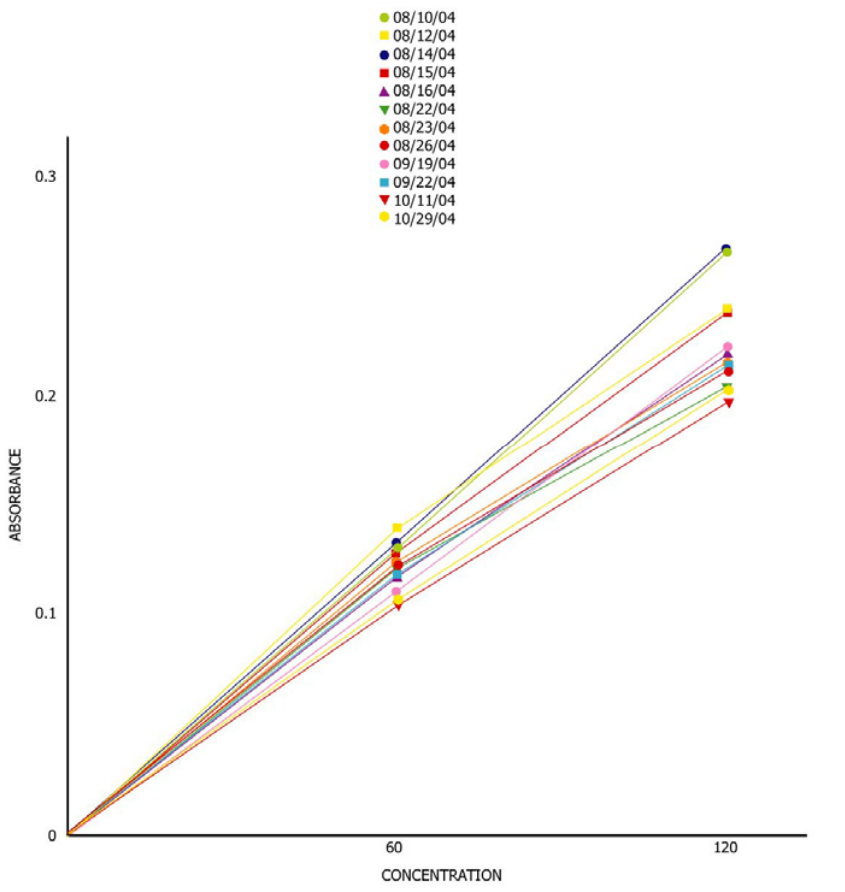
Figure 6. Cr(VI) calibration curves (0, 60, 120 ppb) 2 nd